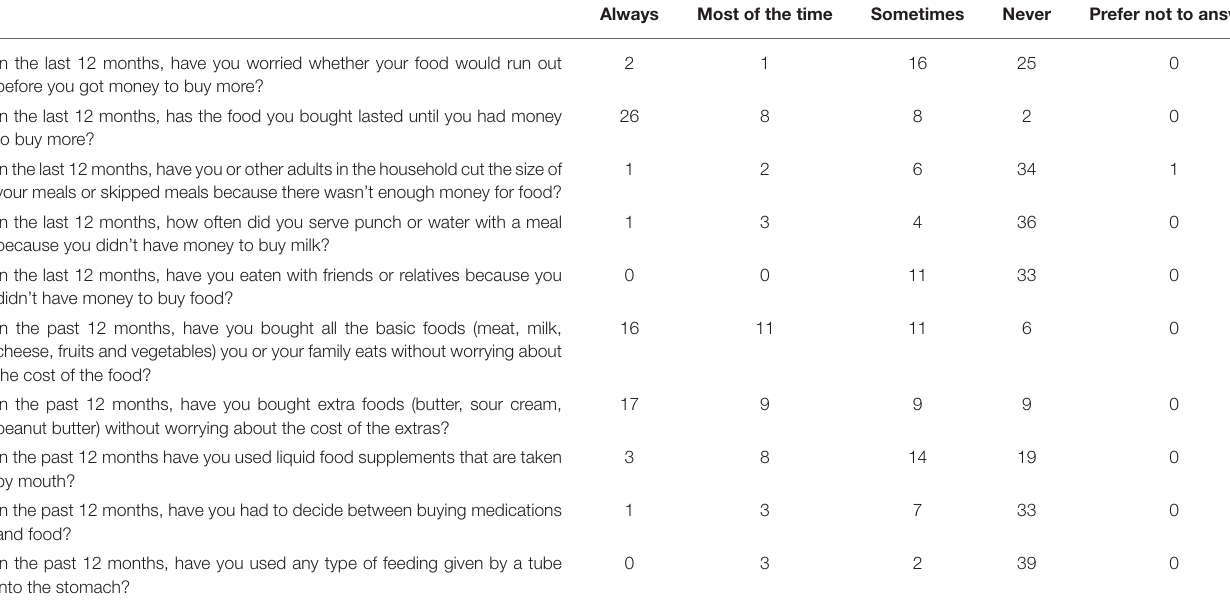
TABLE 3 | Results of food security tool completed by adults with cystic fibrosis. Always Most of the time Sometimes Never Prefer not to